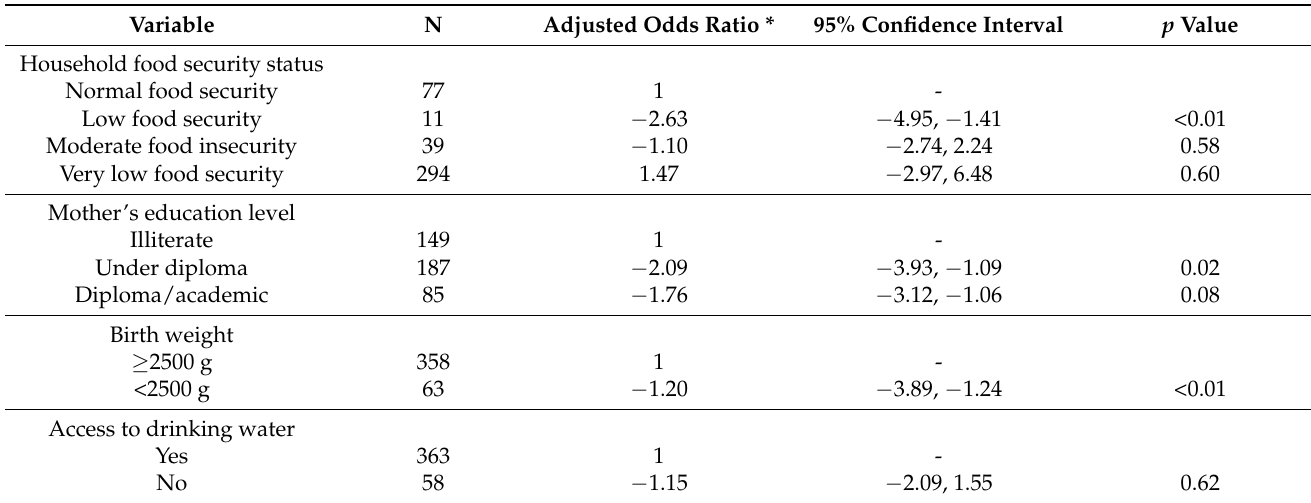
Table 4. Odds ratios for weight for age based on the ordinal logistic regression